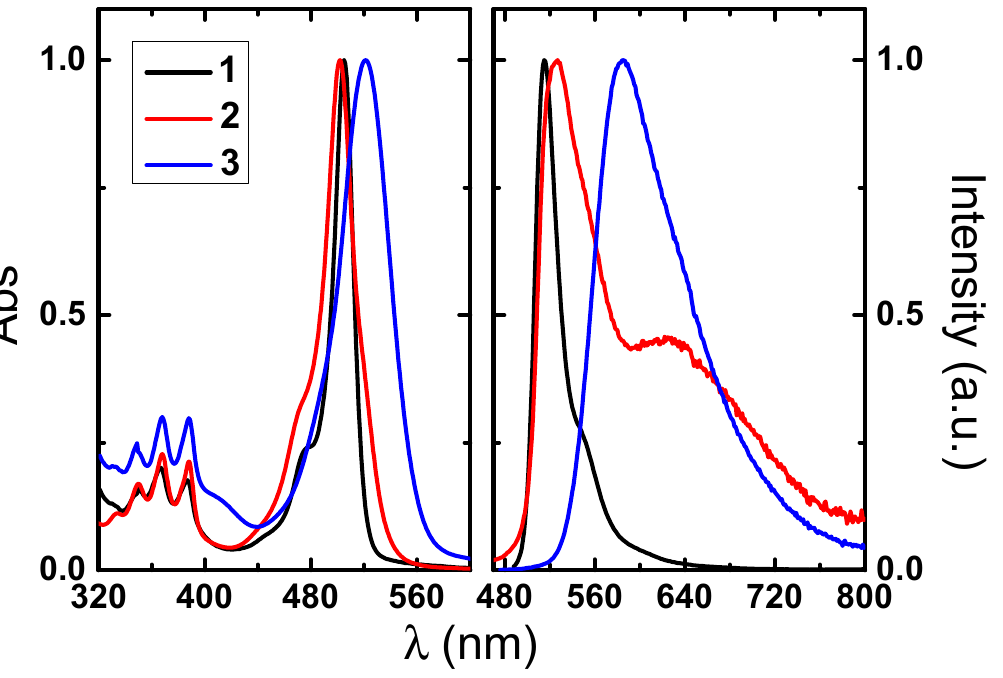
Figure 1. Absorption and fluorescence emission spectra for BODIPYs 1 – 3 in tetrahydrofuran solution at 293 K.